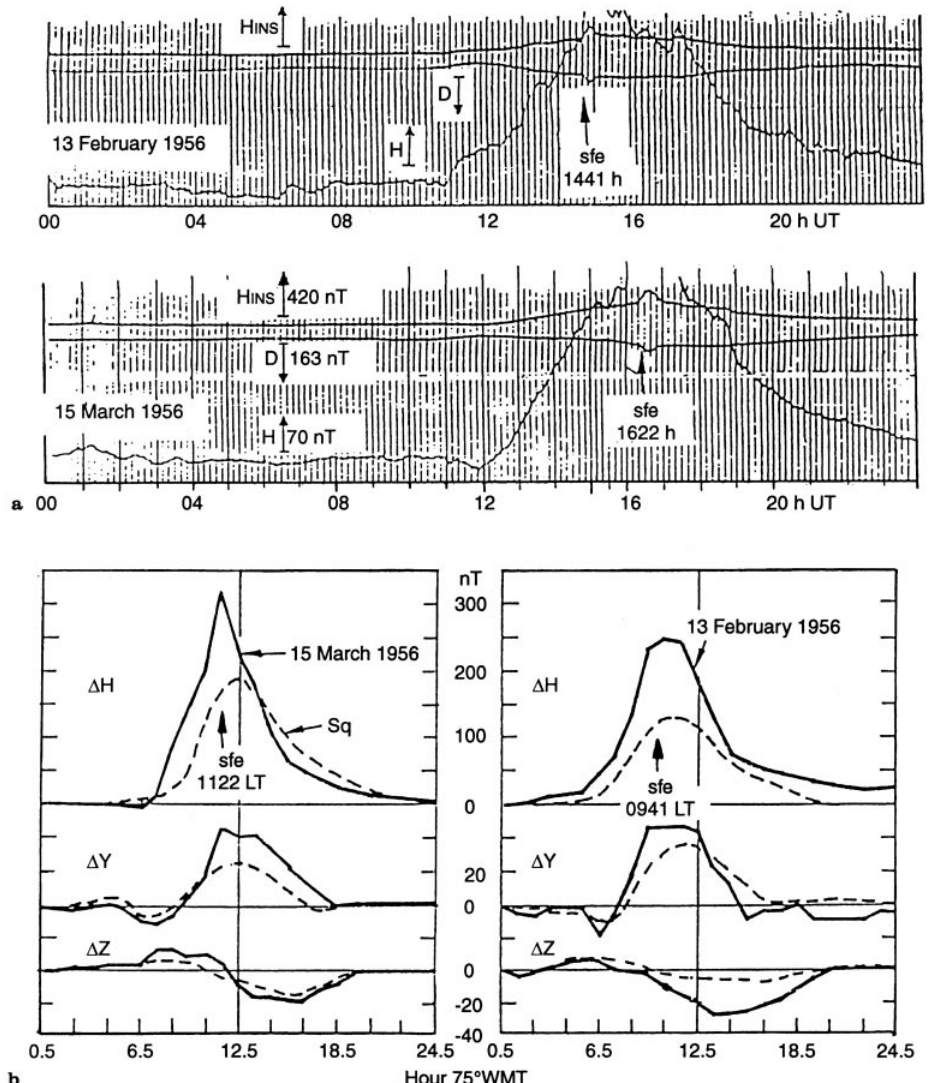
Fig. 8. a Reproductions of mag- netograms at Huancayo during the solar flares on March 15, and February 13, 1956; b solar daily variations of H , Y , and Z on March 15, and February 13, 1956 compared with corresponding monthly mean